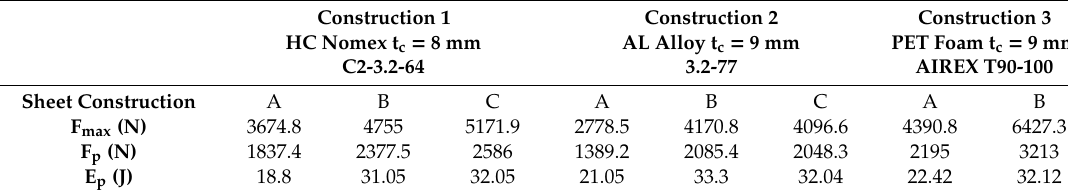
Table 4. Results of impact testing till t c < 10 mm.